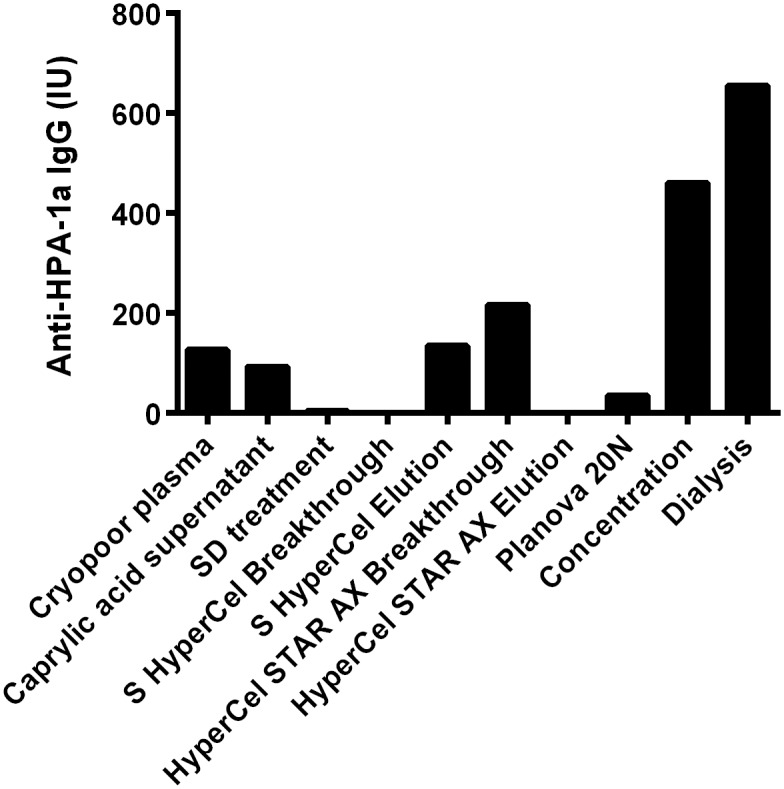
Quantitative monoclonal antibody immobilization of platelet antigen (MAIPA) assay of anti-HPA-1a IgG at different step of the purification process.